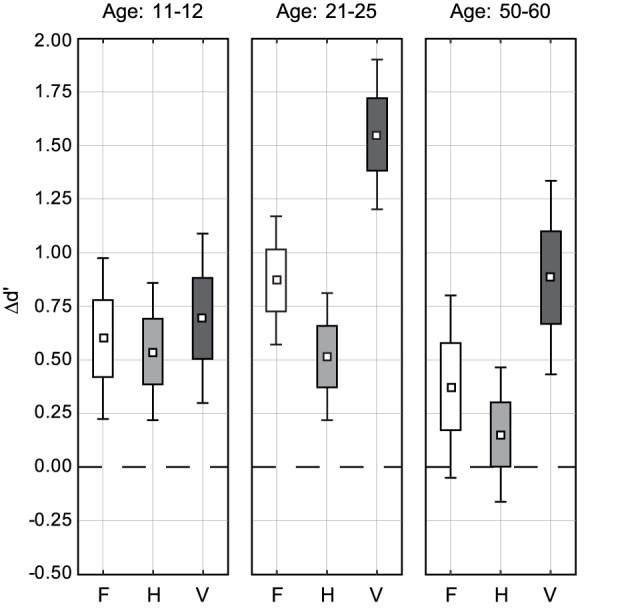
Face inversion effects for the three change types F, H, and V in the three age groups, represented by Box–Whisker plots. The inner box represents the mean IE, the outer box standard error and the Whiskers indicate 95% confidence limits of the mean IE. Note that a IE is significant if 0 (dashed black horizontal line) is outside the confidence interval.